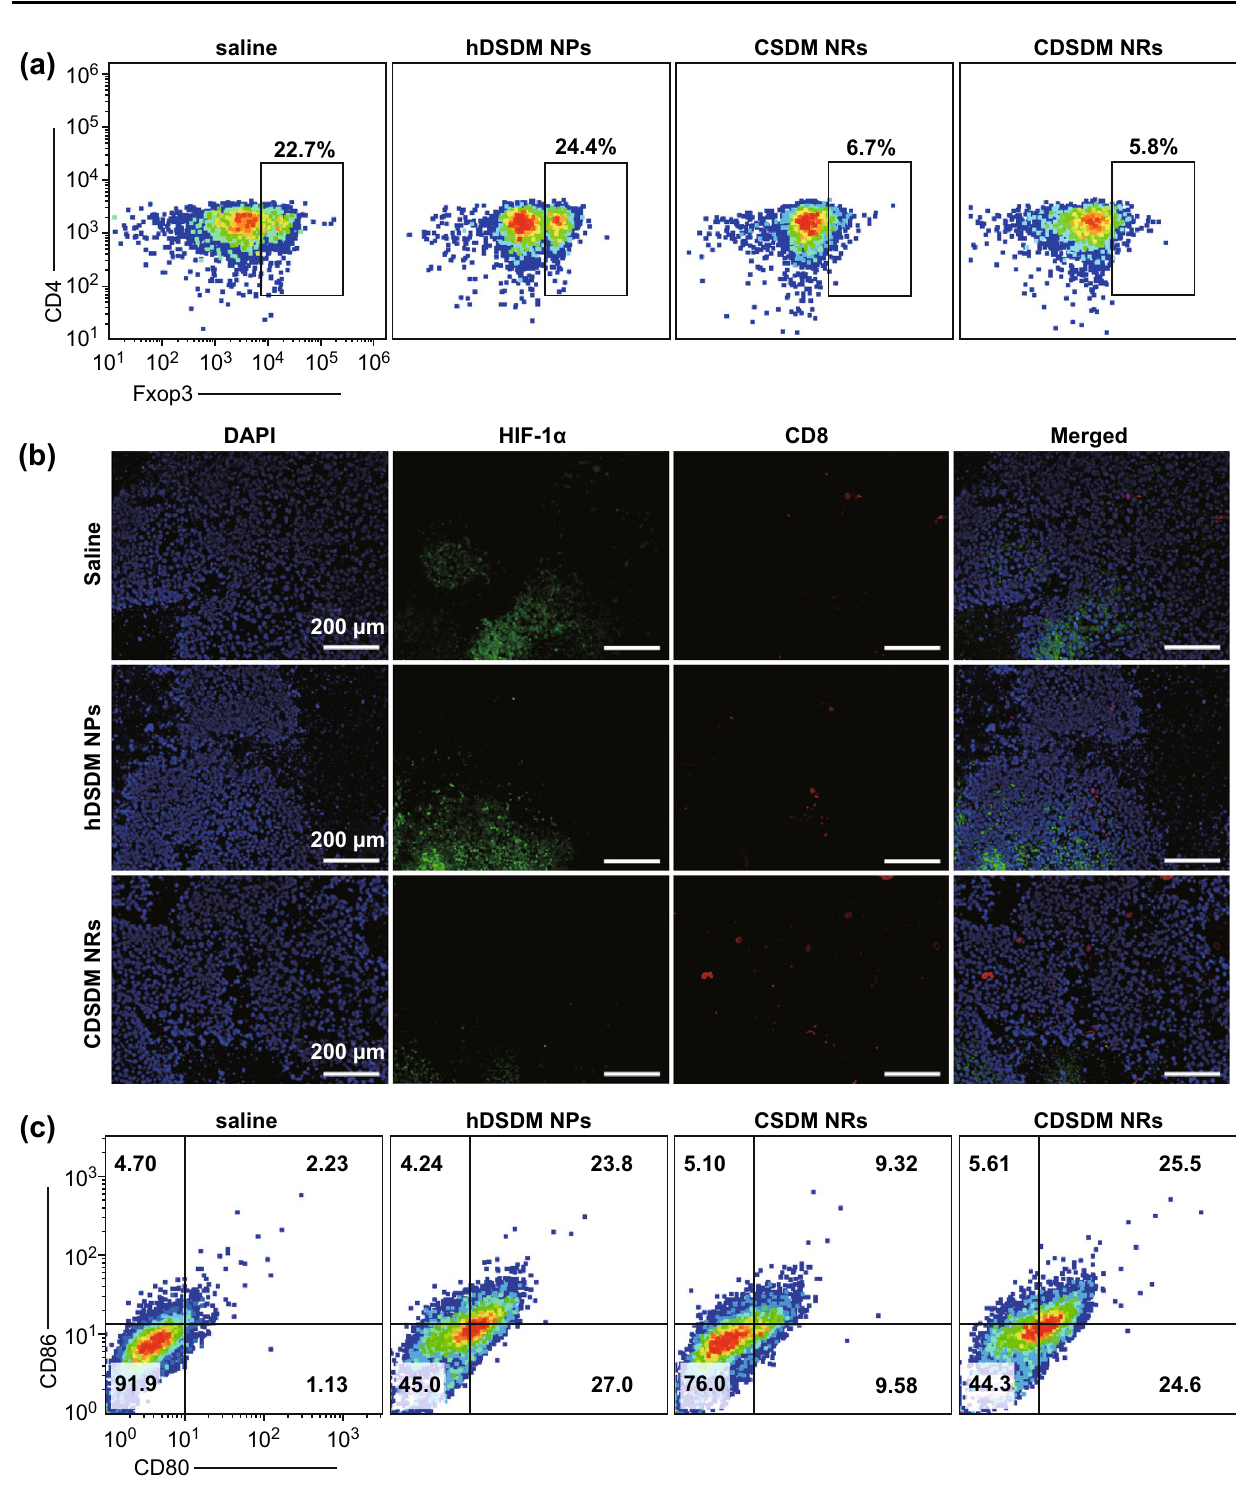
Fig. 5 a Flow cytometry plots showing the percentages of intratumoral Treg (gated on CD25 + T cells) populations from mice after 4 days of the indicated treatments. b Immunofluorescence results of the co‑staining of HIF‑1α and CD8 to deep (> 2 mm from the surface) tumor tissues from mice received 4 days of the indicated treatments. c Flow cytometry plots showing the percentages of CD80 + and CD86 + matured DCs (gated on CD11c+ DCs) from the axillary lymph nodes of mice after 4 days of the indicated